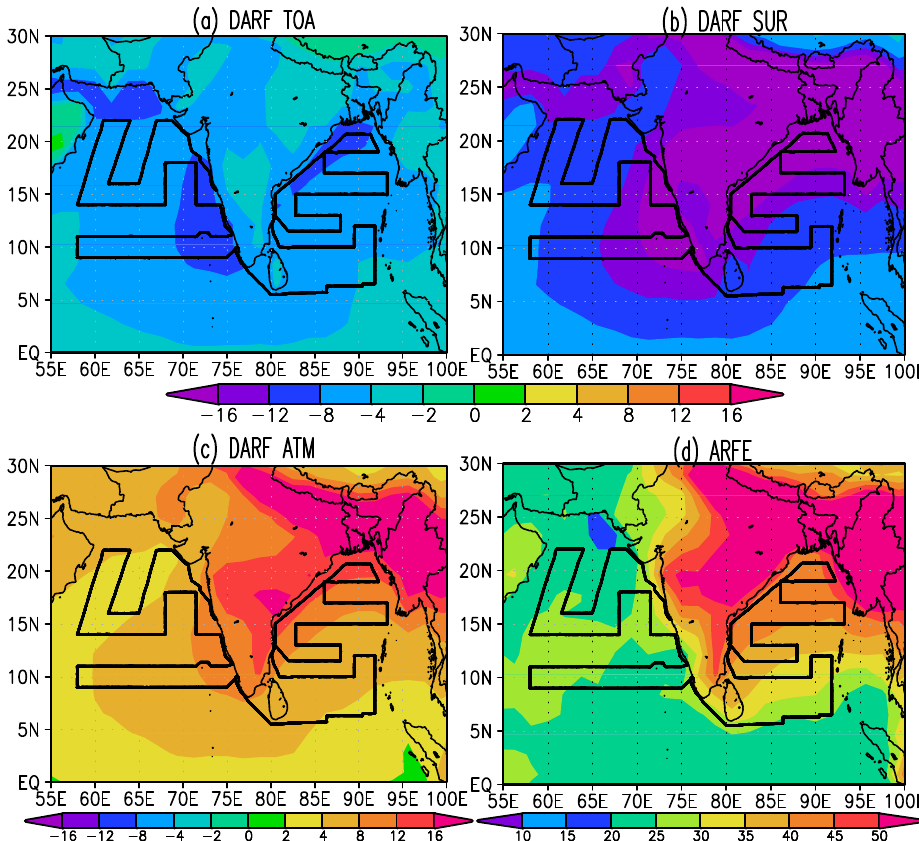
Fig. 7. Spatial distribution of clear-sky shortwave (SW) DARF (Wm − 2 ) at the (a) top of the atmosphere (TOA), (b) surface (SUR), (c) within the atmosphere (ATM) and (d) atmospheric forcing efficiency (ARFE, Wm − 2 τ − 1 )